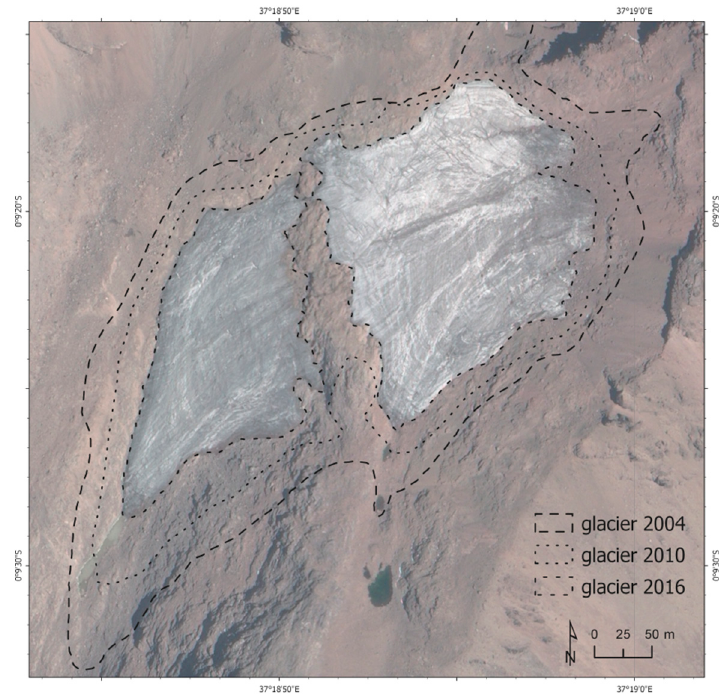
Figure 7. Lewis Glacier seen on the Pléiades orthophoto (pansharpened, nadir) from 23 February 2016. Changes of Lewis Glacier 2004–2016 are depicted by the respective outlines. Former Gregory Glacier, which was still northerly connected to Lewis in 2004, vanished in 2011 [15]. Table 4. Changes of glacier area on Mt. Kenya 2004–2016. Error ranges were derived from horizontal accuracies reported in [13] and this study.